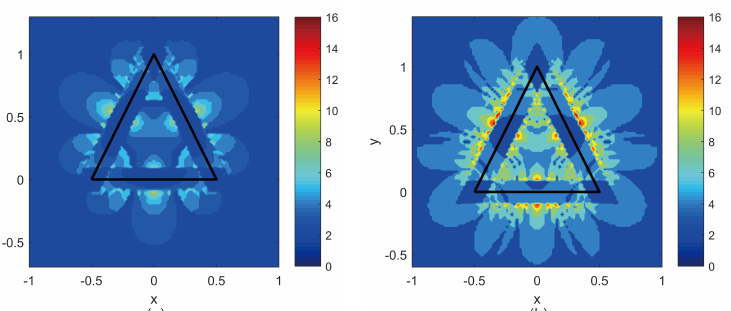
Figure 5. Number of Gaussian quadrature points required for evaluation (15a) in extreme cases ( a ) b i = 10 − 5 , ( b ) b i = 10 − 5 − j 10 − 4